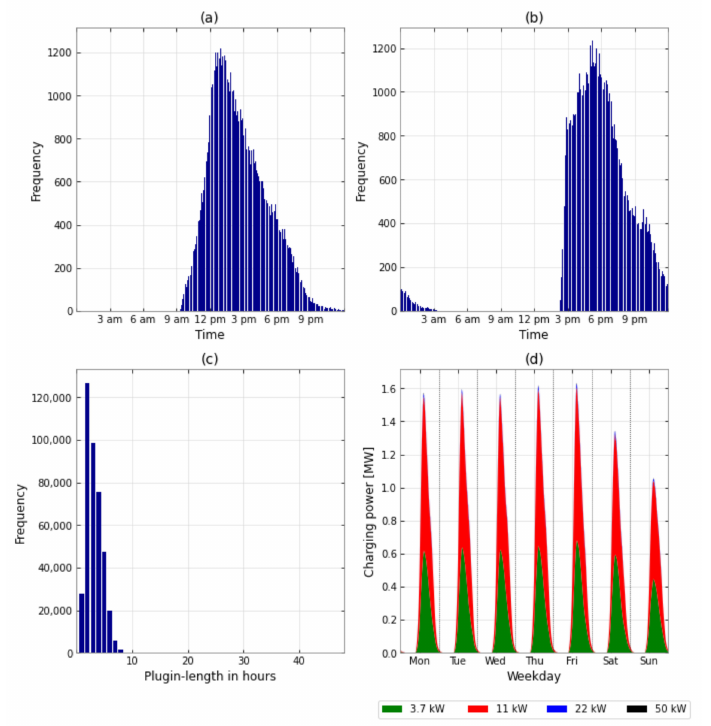
Figure A7. Charging characteristics of temporal charging cluster 5: ( a ) Frequency of different plug-in times; ( b ) Frequency of different plug-out times; ( c ) Frequency of different plug-in lengths; ( d ) Charging power used.